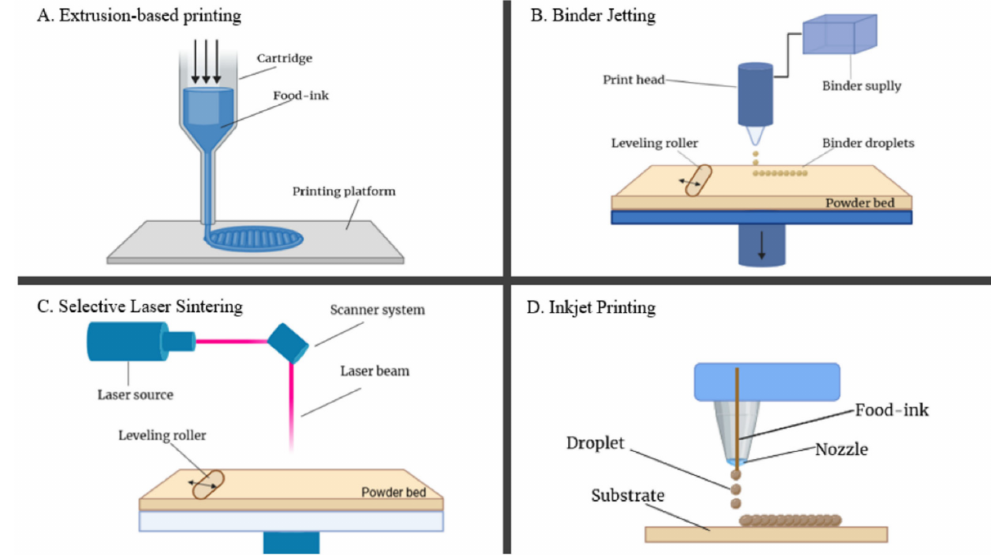
Figure 1. Detailed working diagram of four types of 3D printing technologies: ( A ) extrusion-based printing, ( B ) binder jetting, ( C ) selective laser sintering, and ( D ) inkjet printing. Adapted from Reference [15], with permission from